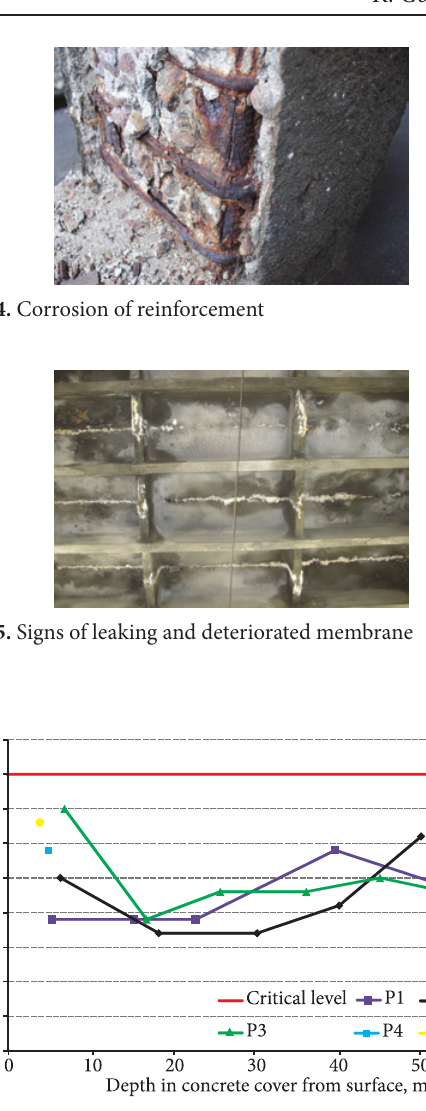
fig. 18. Chloride profiles for bridge over the river Daugava